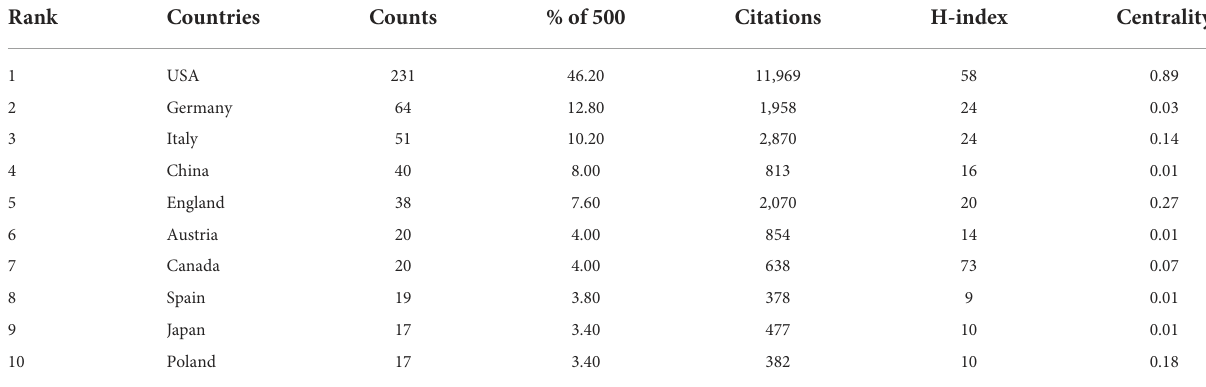
TABLE 2 The top 10 countries/regions in the field of ketogenic diet on cancer research. Rank Countries Counts % of 500 Citations H-index